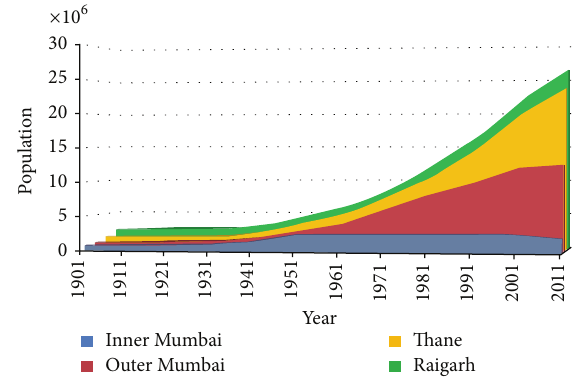
Figure 1: The population growth of Mumbai Metropolitan Region. Source: Urban Age